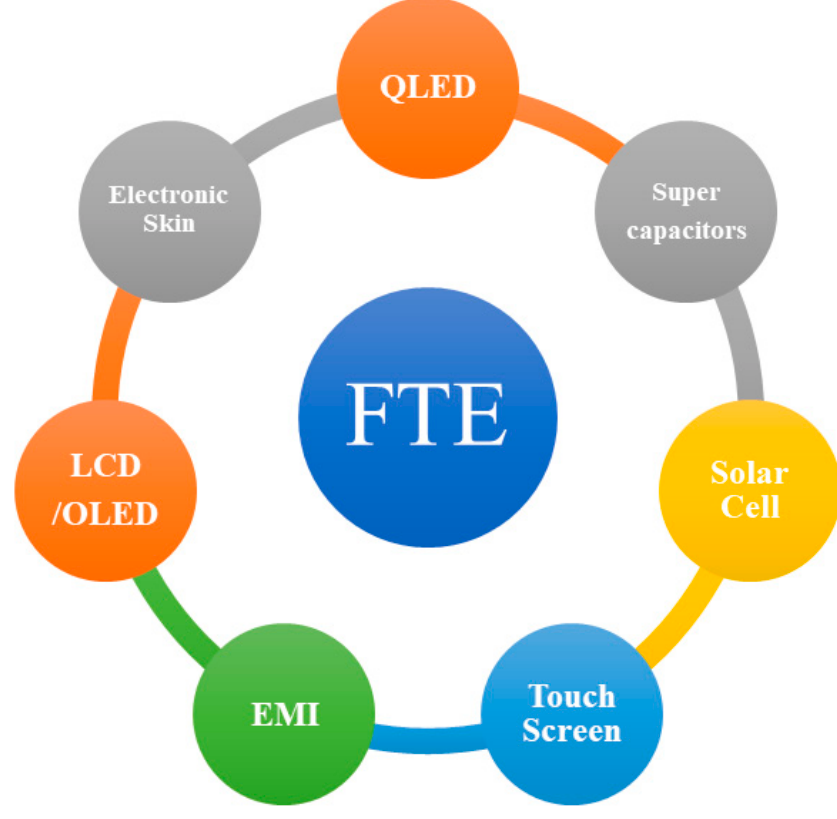
Figure 11. The applications of